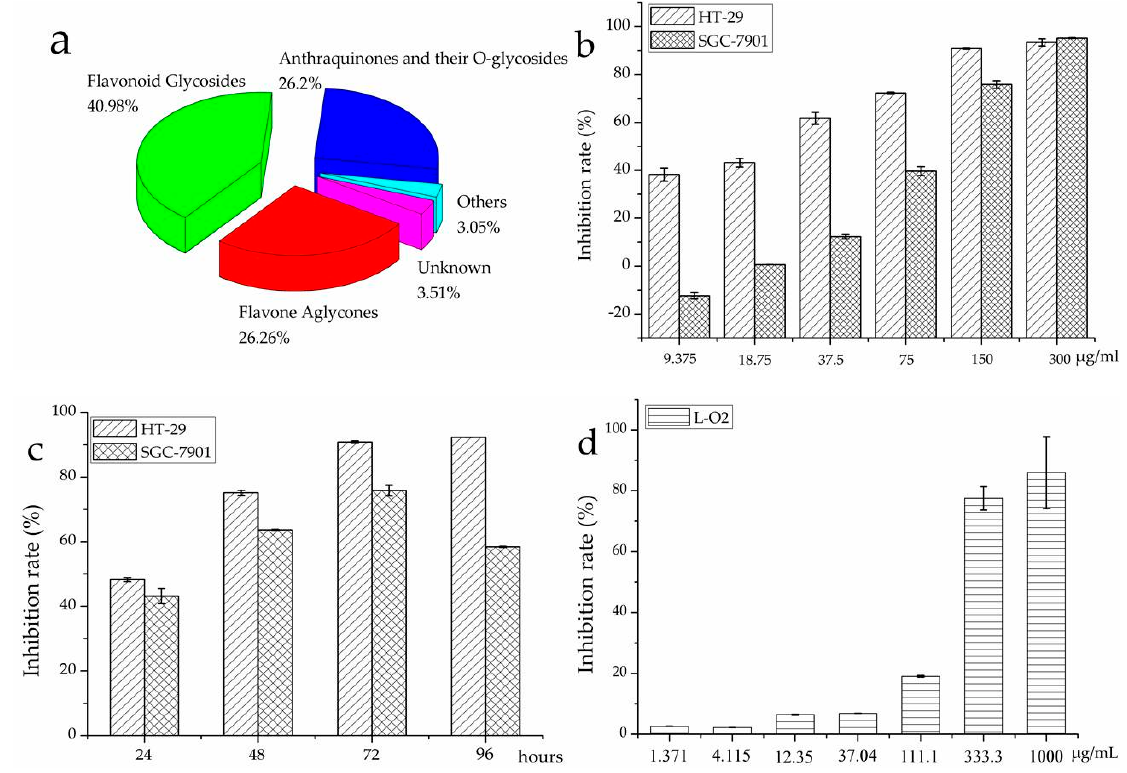
Figure 4. The percentage compositions of different component groups ( a ) from R. davurica and its dose-dependent ( b ) and time-dependent ( c ) antiproliferative activities against HT-29 and SGC-7901 cells and its general toxicity on L-O2 cells ( d ).